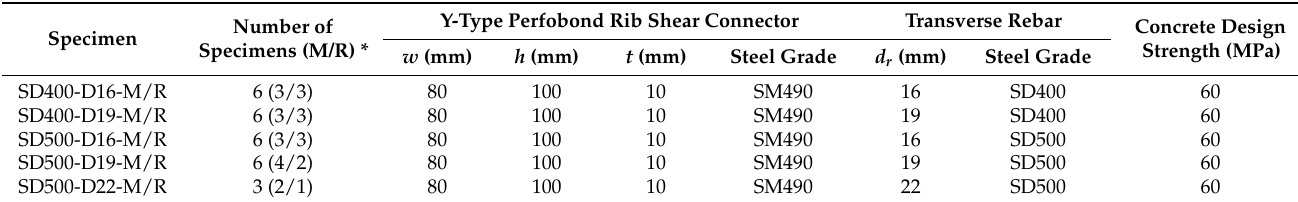
Table 1. Design variables of specimens.